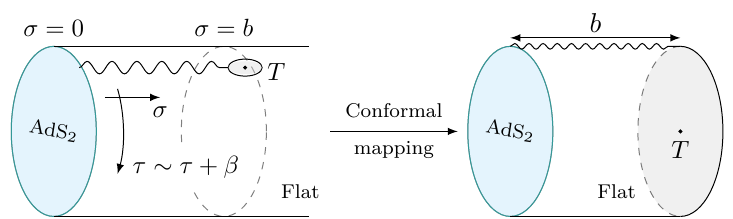
Figure 7. The Euclidean geometry of the model is the semi-infinite cylinder anchored on the boundary of the gravitating disk region [Left]. It can be conformally mapped to the finite cylinder geometry [Right], which is used to calculate the thermal free